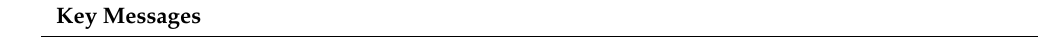
Table 2. Key Takeaway